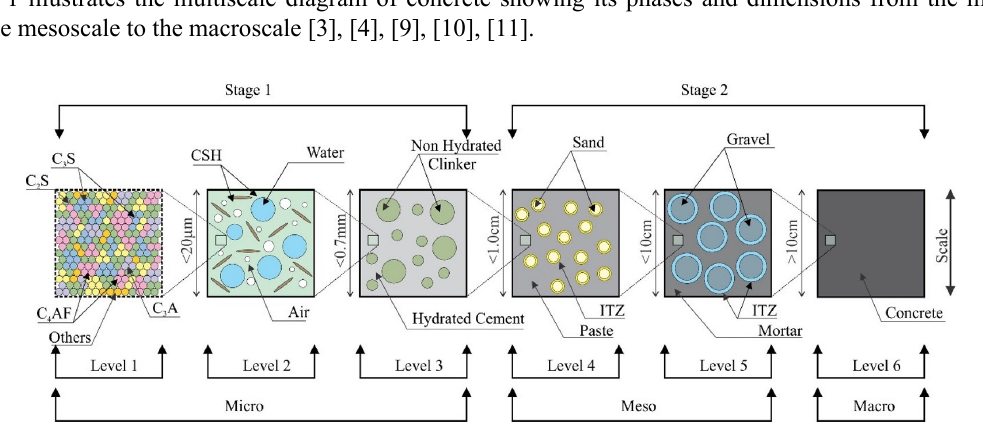
Figure 1: Multiscale micromechanical diagram, processes, levels, and stages of